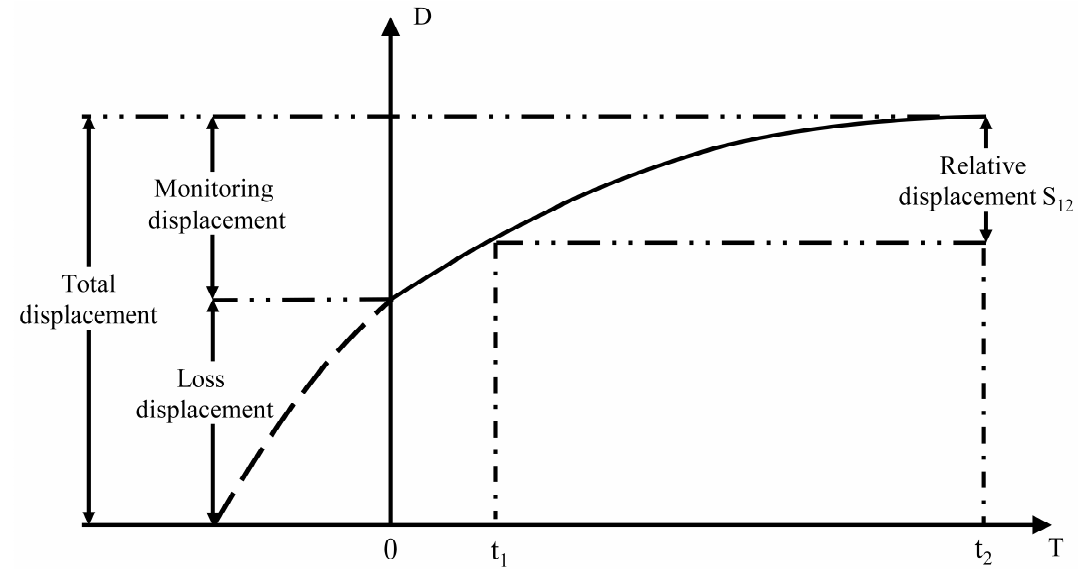
Figure 6. Monitoring displacement and loss displacement.